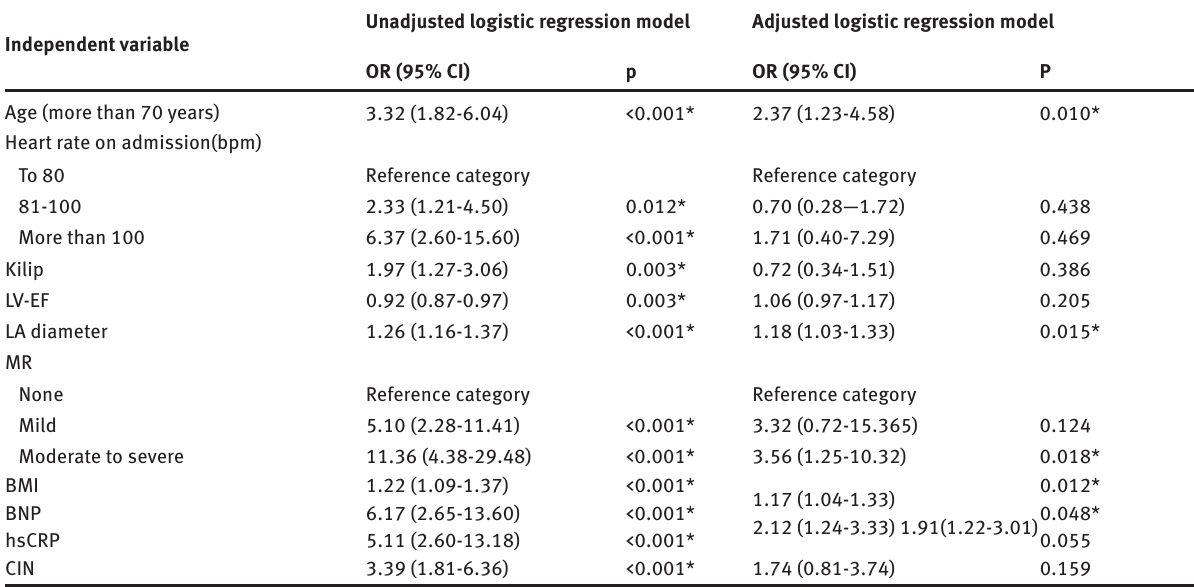
Unadjusted logistic regression